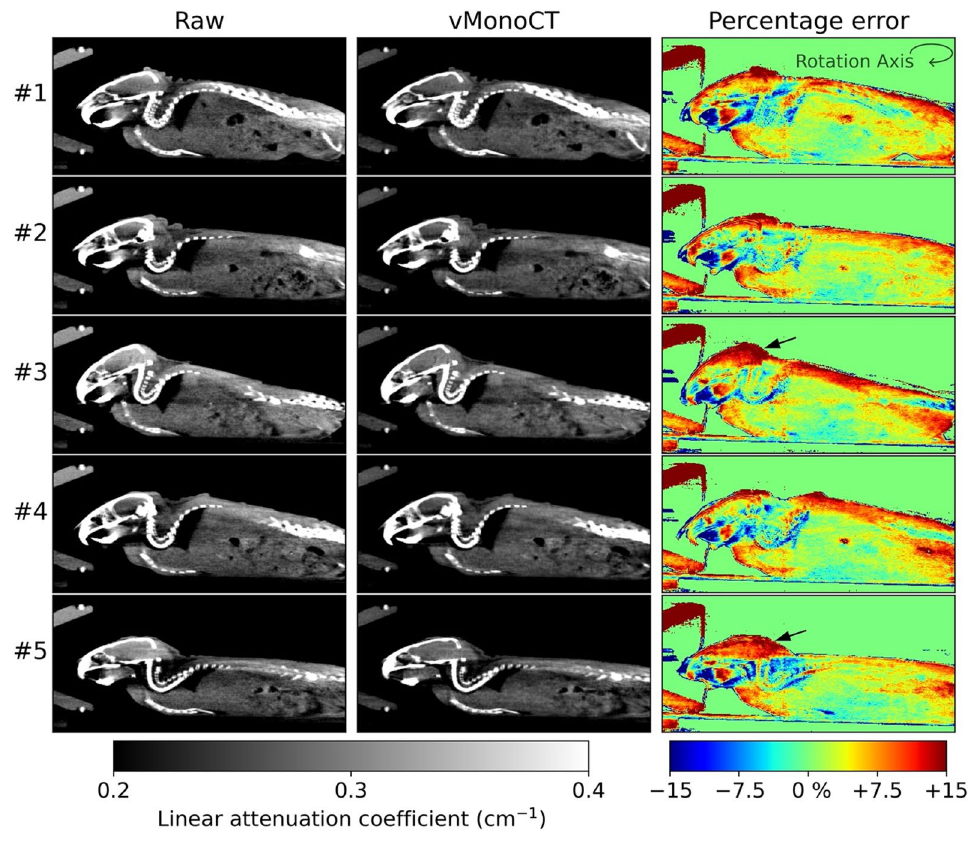
Figure 4. The raw and vMonoCT corrected SARRP µCBCT image reconstructions of a retrospective dataset existing of five mice. The percentage error map is calculated between the raw images, and minus the vMonoCT corrected µCBCT